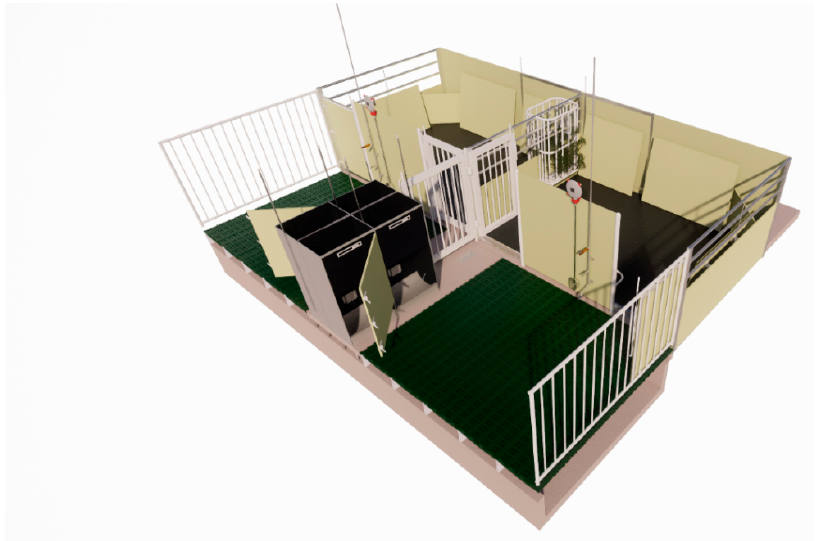
Figure 9. Slightly changed version of the SowComfort farrowing pen into a “from-farrowing- to-30 kg” pen where the litter can remain in their home pen until they are 30 kg. The pen has two feed dispensers and the entrance to the nest area is moved to one of the sides rather than in the middle to strengthen the walls and avoid an extra corner where piglets may choose to defecate and urinate. The drawing was constructed by May Helen Gryte in Fjøssystemer A/S (2019).